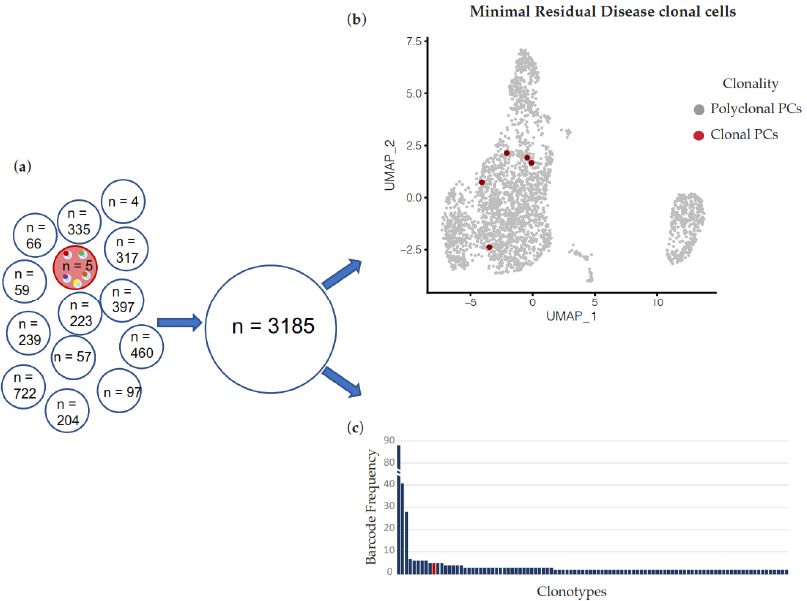
Figure 4. ( a ) In silico dilution of reads from 5 barcodes associated with the dominant clonotype of patient’s sample PLC-10 (red) into reads from 3180 barcodes of 13 different samples. ( b ) UMAP dimension reduction of the simulated sample. Red dots represent barcodes associated with PLC-10- specific V(D)J rearrangement. ( c ) Bar plot of clonotypes’ abundance in the virtual fastq file generated in ( a ) and analyzed by Loupe V(D)J Browser. Clonotypes after the 100th rank according to the barcode frequency are not plotted. The red bar represents the clonotype made up of the five barcodes sharing the myeloma-specific V(D)J rearrangement of PLC-10. The presence of the top- ranked clonotypes displayed at the left of the red bar is dependent on the procedure followed for the generation of the virtual sample, and is compatible with the composition of the V(D)J repertoire observable in a normal sample [17]. 3. Discussion The tumor cell-specific rearrangement in the immunoglobulin V(D)J gene region (particularly at the IGH locus) is already exploited as a target by NGS (both amplicon- and capture-based [18]) or allele specific oligonucleotide (ASO) PCR. Here, the identification of the clonotypic rearrangement is particularly worthwhile also in routine clinical practice, as it represents an extremely specific molecular marker that is useful for monitoring the disease burden along its various stages. Indeed, MRD evaluation is proving more and more useful due to the impact that the depth of the response has on the outcome, and it could also act as a rapidly assessable surrogate trial endpoint, thus bridging the increasing delay between drug development and approval. Overall, our findings argue that scRNA-seq provides robust and accurate data to derive the sequence of such clonal V(D)J rearrangements in single-cells. Specifically, in our study cohort, this approach proved even more effective in identifying clonal